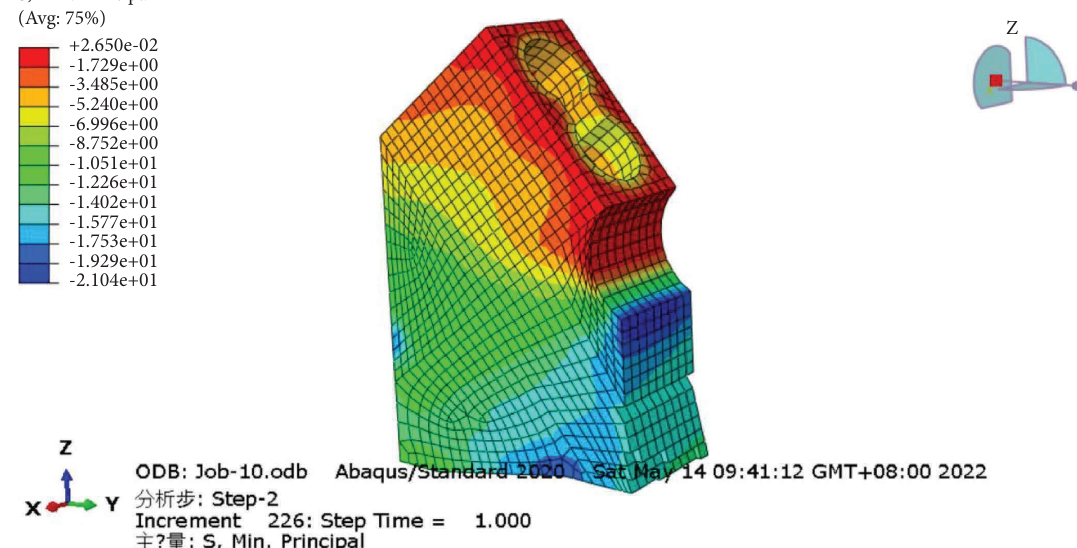
Figure 13: Cloud chart of the principal compressive stress of arch foot without anchorage of condition